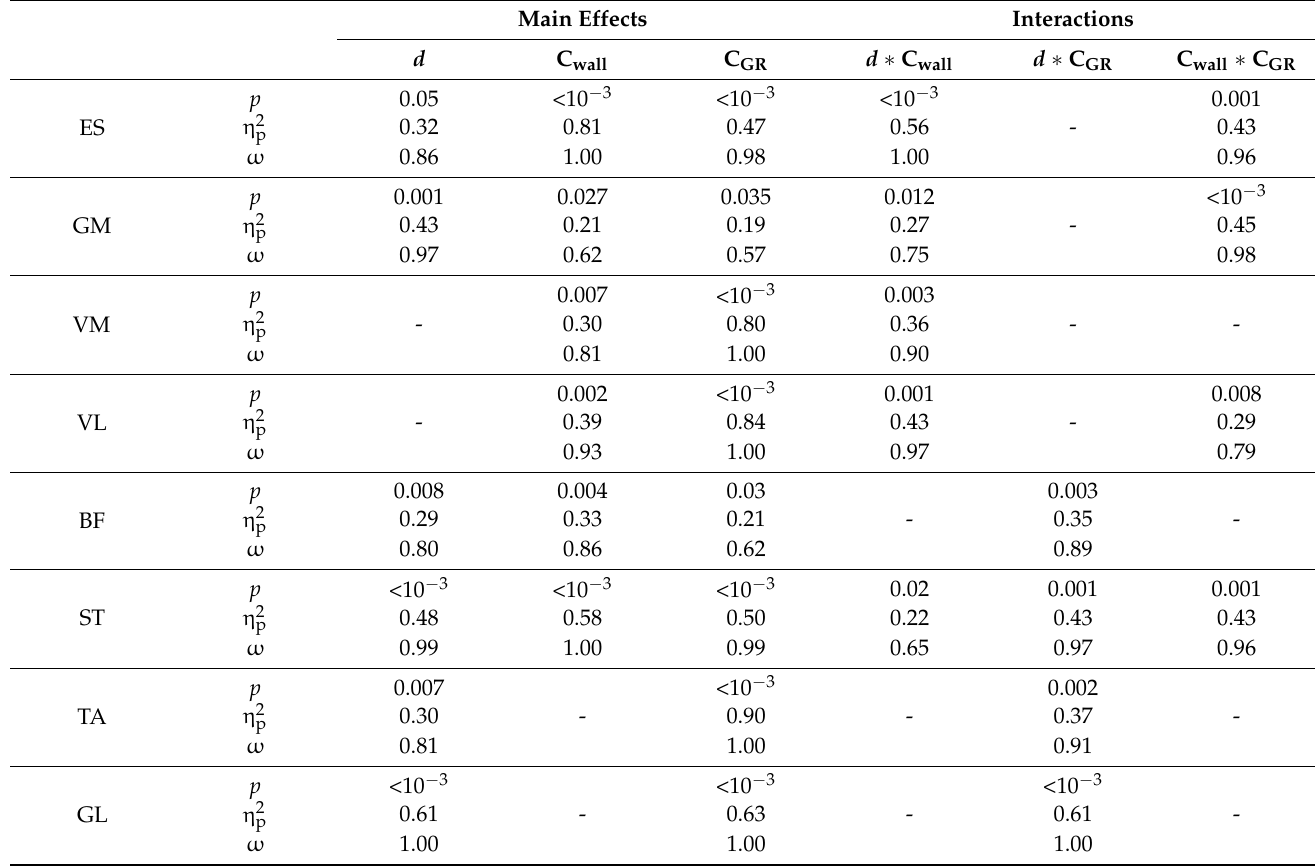
Table 2. p -value, effect size (partial eta squared η 2 p ), and statistical power (observed power ω ) for main effects and interactions as deduced by the three-way ANOVA analysis. The statistical parameters are reported only for main effects and interactions with p < 0.05. No statistically significant effect was detected for the d ∗ C wall ∗ C GR interaction. Main effects: (1) change in ankle–wall distance d between d 1 = 0.5 · l thigh and d 2 = l thigh ; (2) shift in C wall between the scapular and pelvic zone; (3) shift in C GR between rearfoot and forefoot. ES = erector spinae, GM = gluteus maximus, VM = vastus medialis, VL = vastus lateralis, BF = biceps femoris, ST = semitendinosus, GL = gastrocnemius lateralis, TA = tibialis